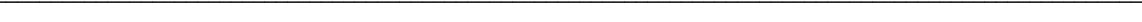
Fig. 5. Psammosteus ramosus sp. nov. Glinskiy, rooted tessera and topographic variability of the ornament ( A – F ). Shots of ornamentation are shown in Fig. 3; micromeric elements of the ‘basic type’ in some species of Psammosteus and their microstructure ( G – S ). A , PM SPU 80-2, holotype, rooted tessera, fragment of left branchial plate, Andoma Hill, Russia. B , C , G 43/292:1, fragment of branchial plate. D – F , G 43/292:2, fragment of left branchial plate. G – J , PM SPU 75-12, Psammosteus maeandrinus Agassiz, 1844, discrete tessera, Andoma Hill (outcrop OK-3, layer 5), Russia (Upper Devonian, Frasnian, P ļ avi ņ as RS); G, lateral, H, anterior and I, top views, J, vertical section. K – N , PM SPU 75-13, Psammosteus megalopteryx (Trautschold, 1880), discrete tessera, Lake Il  men  (outcrop 11/56, sample B4), Russia (Upper Devonian, Frasnian, Daugava RS); K, lateral, L, anterior and M, top views, N, the vertical section. O – Q , PM SPU 71-5, Psammosteus livonicus Obruchev, 1965, discrete tessera, Yam-Tesovo, Russia (Upper Devonian, Frasnian, Amata RS); O, lateral and P, top views, Q, vertical section. R , S , GIT 680-380, Psammosteus bergi (Obruchev, 1943), discrete single element, Essi (Essi müür), Estonia (Middle Devonian, Givetian, Burtnieki RS); R, lateral view, S, vertical section. G–S, MicroCT images. Abbreviations: a.t., aspidin trabeculae; p.c., pulp cavity; p.t., primordial tubercle; s.t., satellite